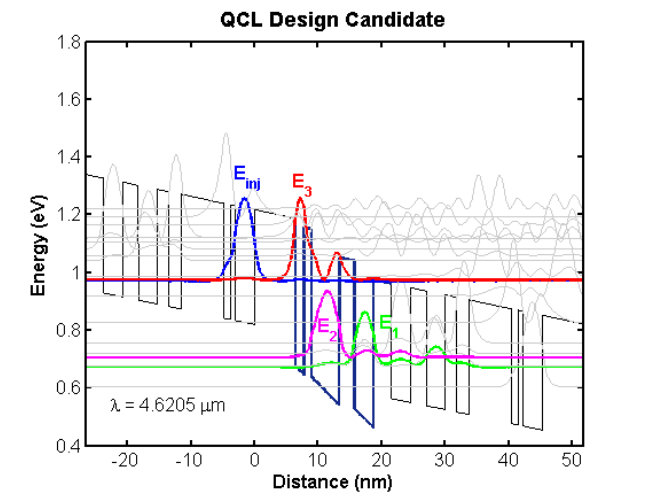
Figure 7. Al x Ga 1 − x As/In y Ga 1 − y As QC laser candidate simulated on GaAs (111) with top aggregate fitness rank given a training initial population. In this design, x = 0.21 and y = 0.25 and the layer sequence (in nm) starting with the first injector well is: 3.0, 2.5 , 3.0, 1.8 , 2.0, 6.6 , 1.1, 0.8 , 3.0, 6.4 , 1.4,